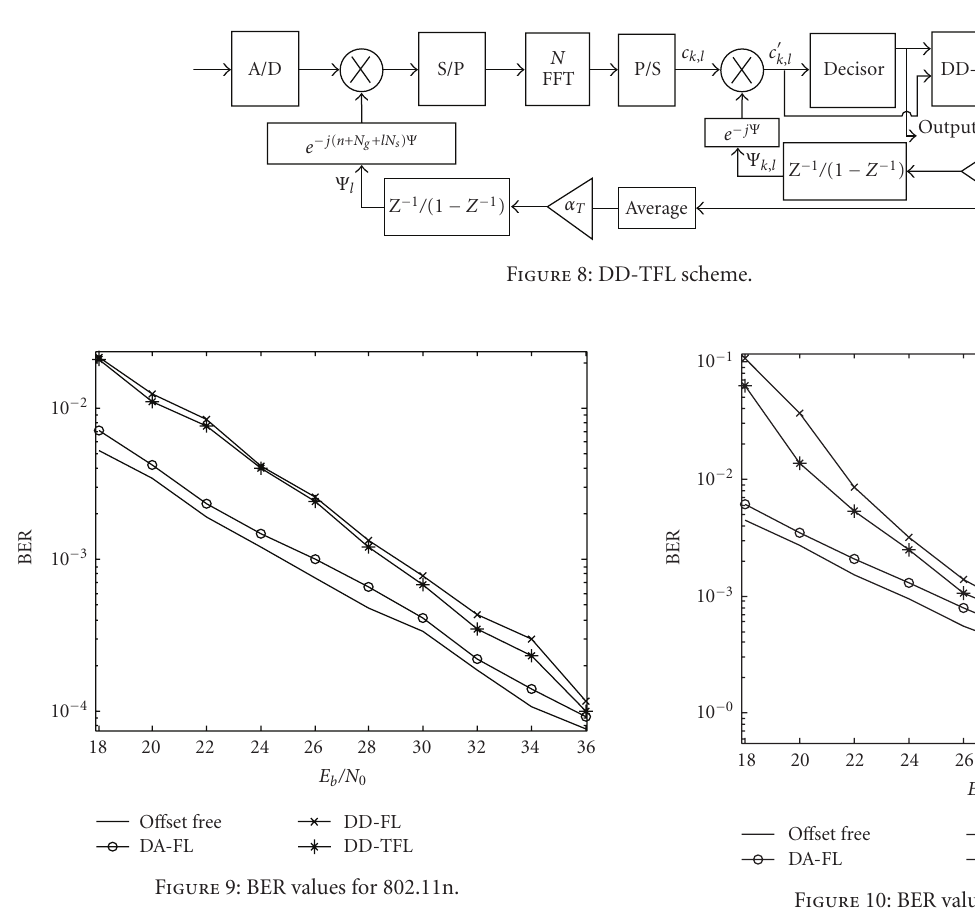
Figure 10: BER values for 802.16d. Table 3: Number of operations and